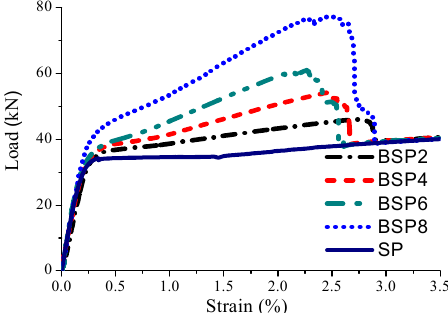
Figure 8. Load-strain curves comparing BSP specimens and the SP